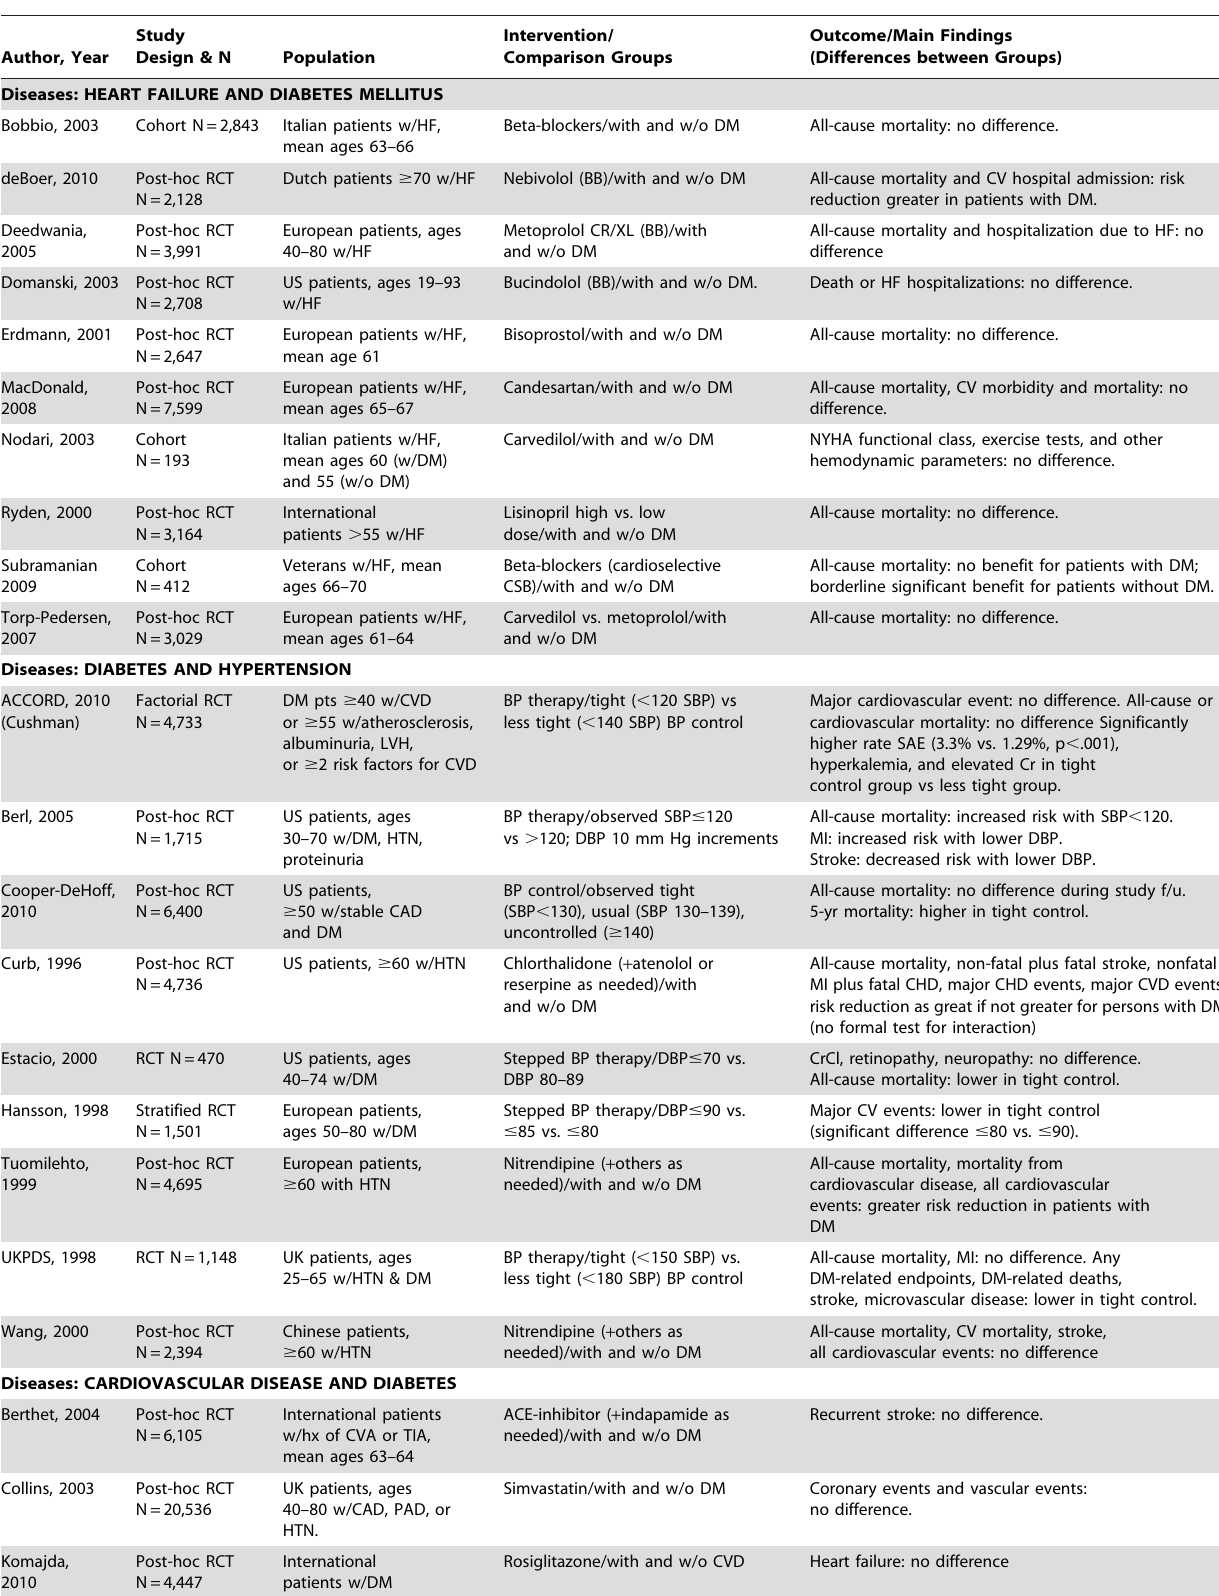
Table 3. Studies identified in systematic